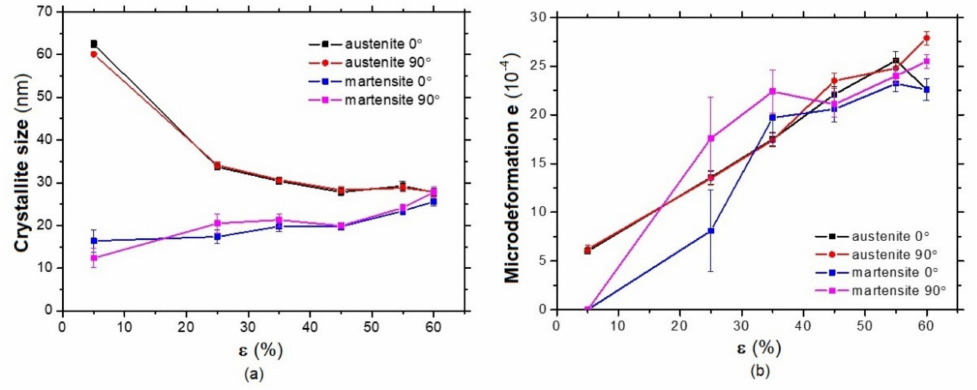
Figure 8. Crystallite size and microdeformation versus ε . ( a ) crystallite size, ( b )